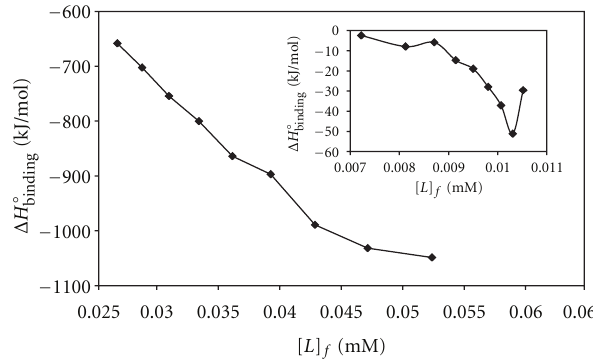
Figure 8: Molar enthalpies of binding in the interaction between CT-DNA and [Pt(bpy)(Oct-dtc)]NO 3 and the inset for [Pd(bpy)(Oct-dtc)]NO 3 versus free concentrations of complexes at pH 7.0 and 300 K.